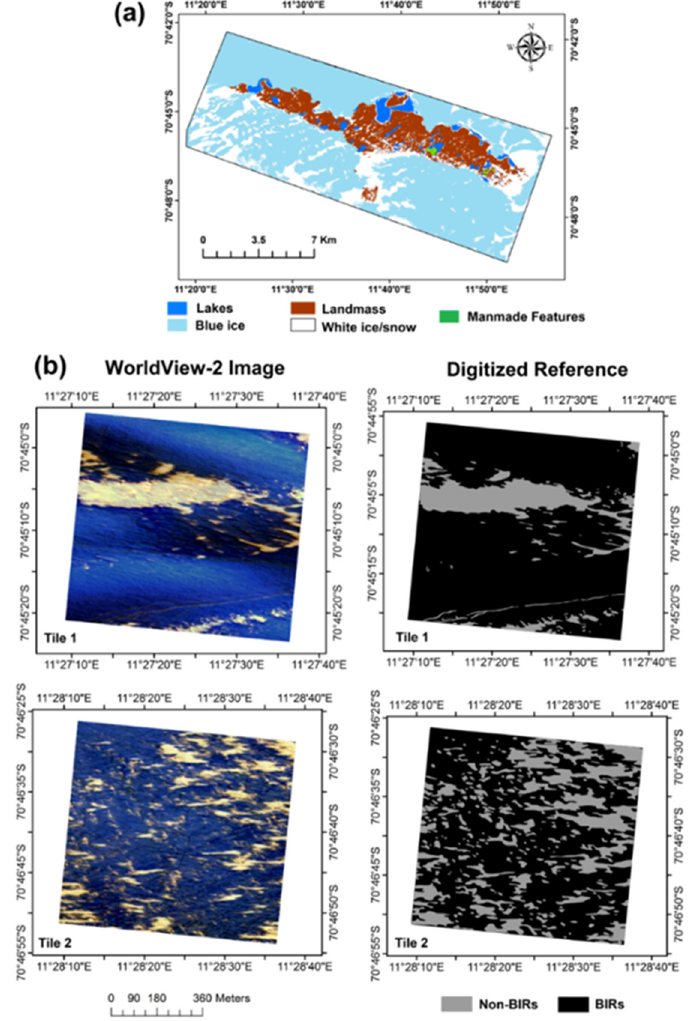
Figure 2. ( a ) A reference manually digitized land cover map showing the spatial distribution of BIRs over the entire study region; and ( b ) sample WV-2 imagery and reference digitized datasets for two tiles (Tile 1 and 2). Table 2. Sample data summarizing the reference BIRs (manually digitized and cross-verified with ground surveying) for the 12 tiles and their respective non-BIR areas (snow/ice/supraglacial debris, streams etc.). Topographic distribution of tiles is highlighted with coloured text and background; (i) tiles on comparatively lower elevation areas are highlighted in violet text (Tiles 8, 9, 12), (ii) tiles on comparatively higher elevation areas are highlighted with green text (Tiles 2, 4, 6), (iii) tiles on intermediate elevation areas are highlighted with red text (Tiles 1, 3, 5, 7, 10, 11), (iv) tiles including shadow-prone areas are highlighted with underlined text (Tiles 8, 9), and (v) Tiles including non- shadowed areas are highlighted with blue background (Tiles 1, 2, 3, 4, 5, 6, 7, 10, 11, 12). Spatial distribution of tiles based on surface area of BIRs is highlighted with bold italics underlined (<65% blue ice, comparatively low blue ice, Tiles 6, 8, 9), bold underlined (>80% blue ice, relatively high blue ice, Tiles 1, 3, 4, 5, 7), and bold italics (65–80% blue ice, Tiles 2, 10, 11, 12). Reference BIRs Reference Non-BIRs Tile